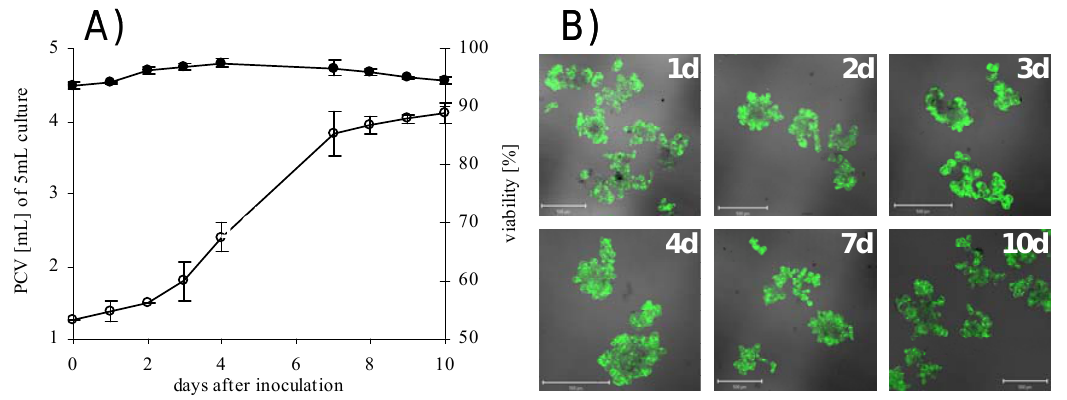
Figure 1. Growth curve and viability of S2LS3 cell